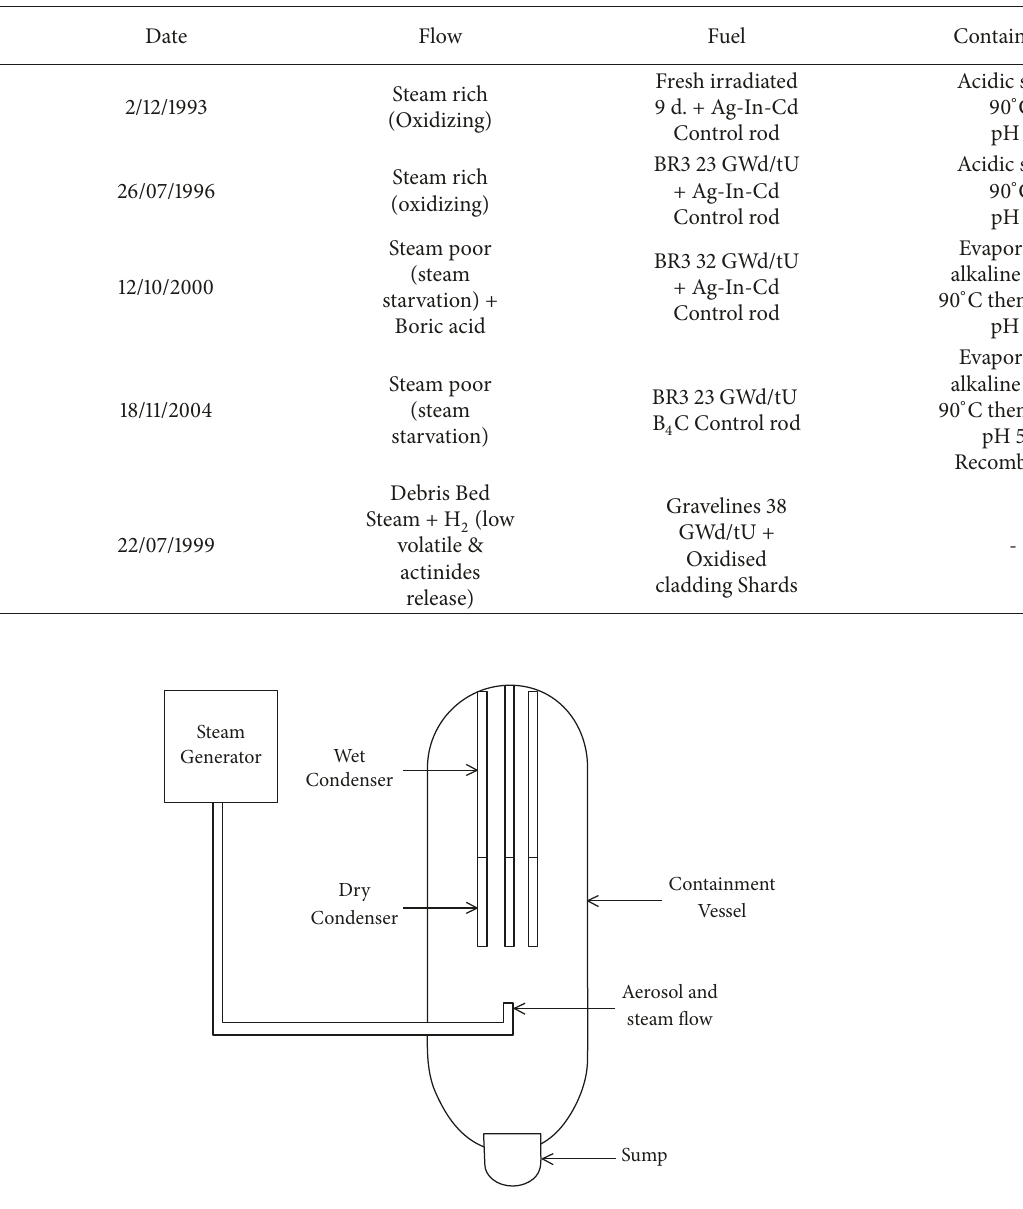
Figure 1: Geometry of Ph´ebus FPT containment vessel